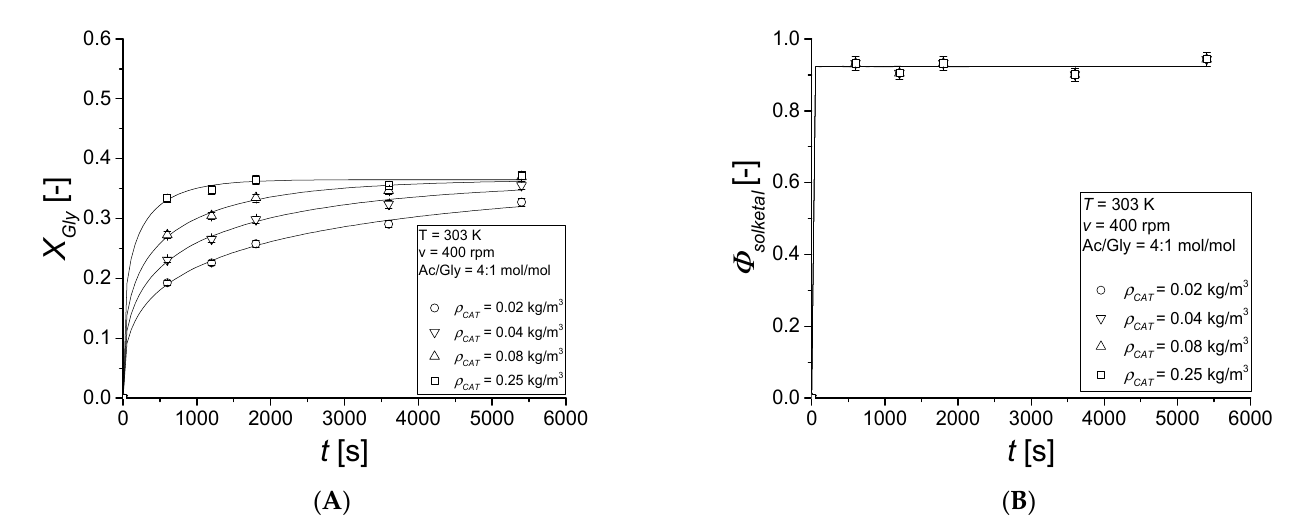
Figure 4. Catalyst load effect for catalyzed tests, fixing v = 400 rpm, Ac/Gly = 4:1 mol/mol, and T = 303 K. ( A ) Glycerol conversion. ( B ) Selectivity toward solketal.